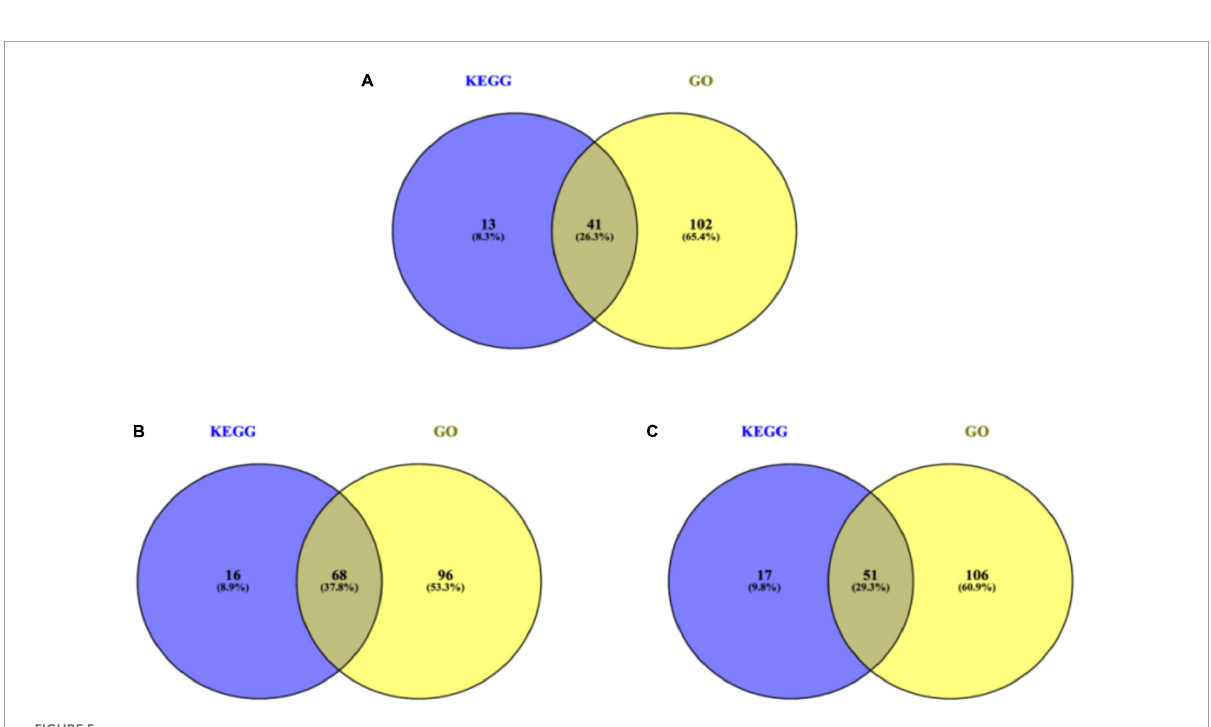
FIGURE5 The number of genes in each intervention group. (A) CF group vs. model control group. (B) Luteolin group vs. model control group. (C) Luteoloside group vs. model control